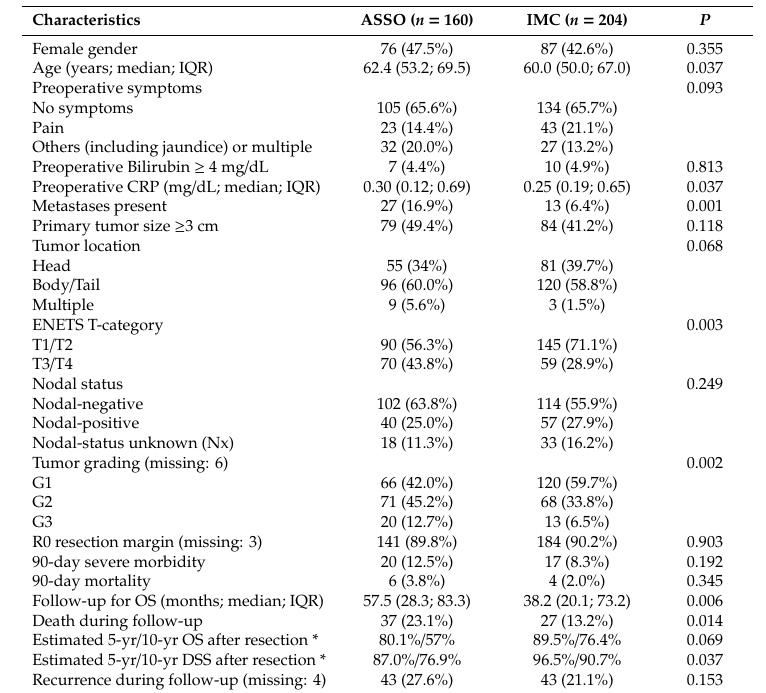
Table 1. Comparison of the national Austrian Society of Surgical Oncology (ASSO) cohort and international multicenter cohort (IMC) of patients undergoing curative intent surgery for pancreatic neuroendocrine neoplasm